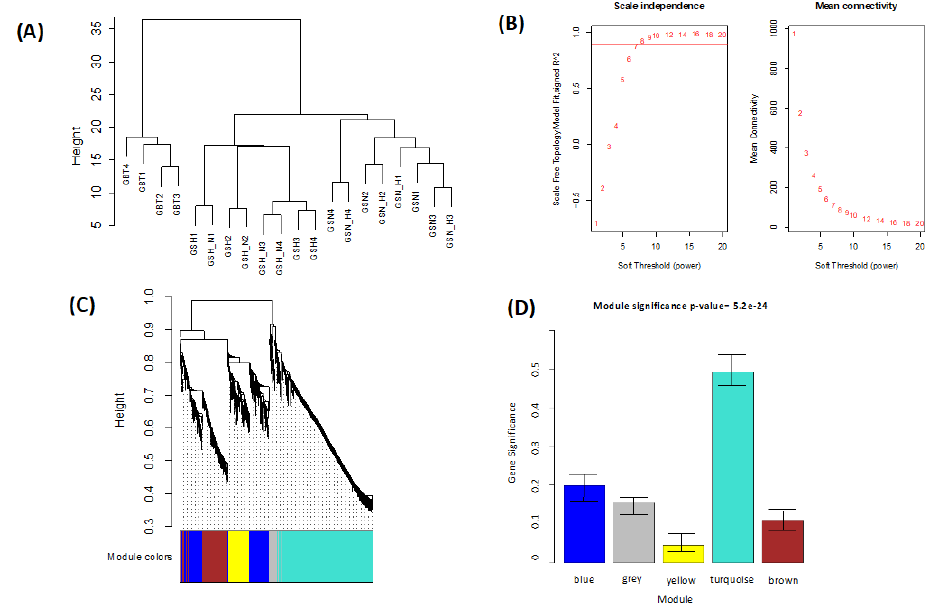
Figure 3. ( A ) Treatment samples clustering to identify outliers of GSE45117: Treatments dendrogram. ( B ) Identification of soft-thresholding power in the WGCNA. (left) The plot of the scale-independent fitting index for numerous soft-thresholding powers ( β ). (right) The plot of the average connectivity for numerous soft-thresholding powers. ( C , D ) Identification of modules linked to the tumor treatments of GSE45117. ( C ) Clustered dendrogram of all the DEGs with a dissimilarity measure (1-TOM). ( D ) Bars of the mean gene significance distribution and each module’s error on the corresponding bar linked to the treatments of GBM.